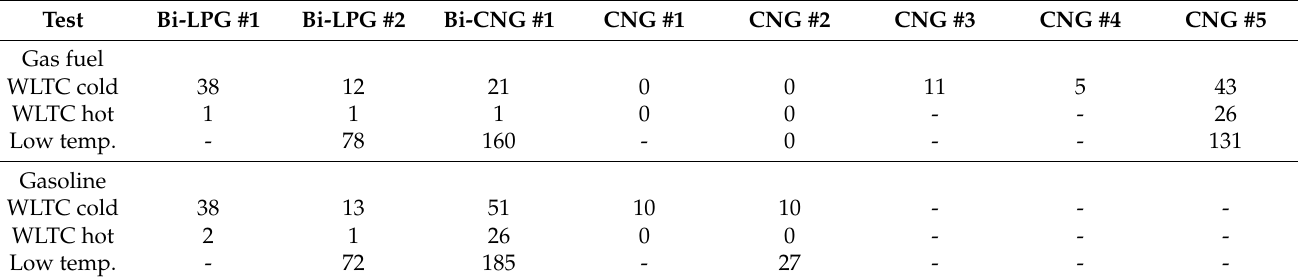
Table 3. Non methane hydrocarbons (NMHC) emissions (in mg/km) in the laboratory. Dashed lines mean that no measurements are